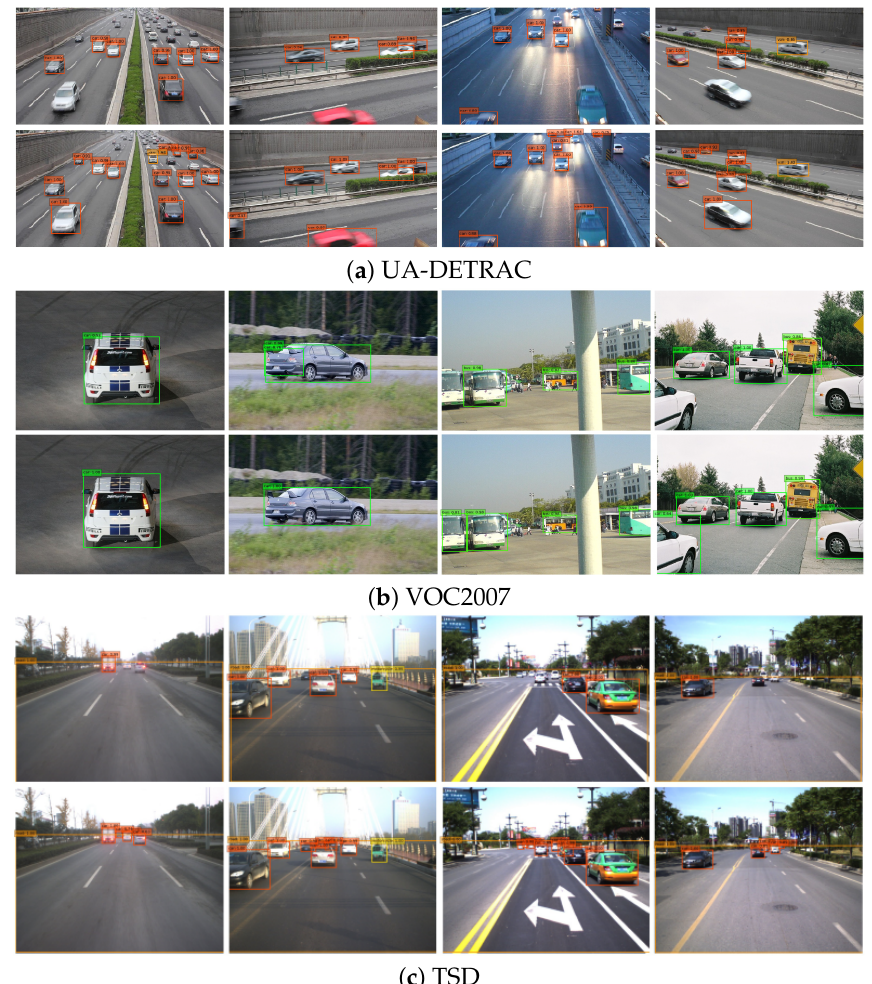
Figure 7. Qualitative comparative